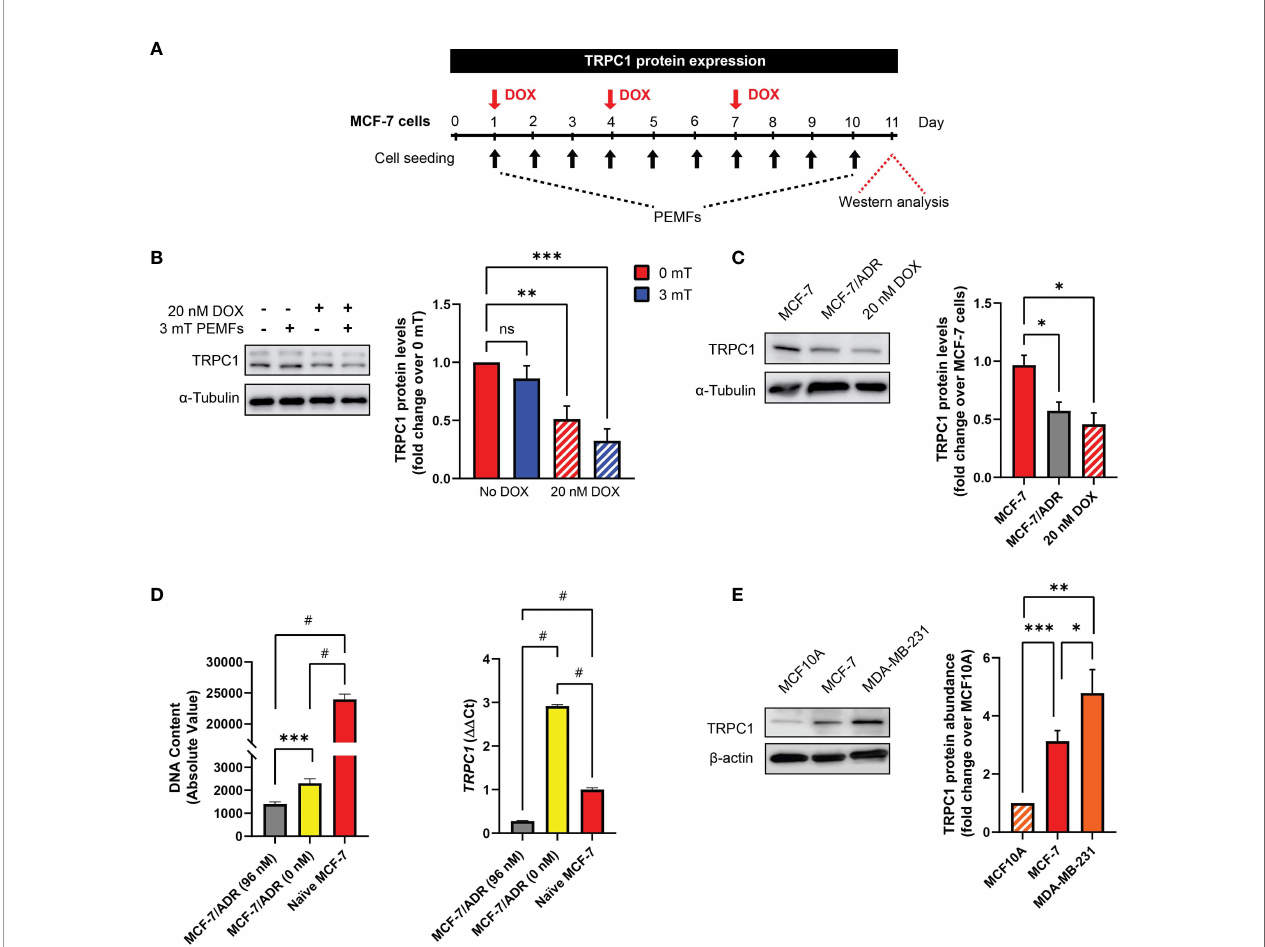
FIGURE 5 | DOX-chemoresistance is associated with TRPC1 channel downregulation. (A) PEMF (black arrows, 3 mT) and DOX (red arrow, 20 nM) regime used for TRPC1 protein analysis. (B) Representative western blot showing changes in TRPC1 after 11 days under the indicated conditions and corresponding quanti fi cation of TRPC1 protein levels normalized to unexposed 0 mT. Cells treated with DOX are represented by the hatched bars in combination with either 0 mT (red) or 3 mT (blue) PEMF exposure. (C) Western blot analysis of TRPC1 protein levels in MCF-7/ADR (96 nM DOX; gray) and 10-day 20 nM DOX-treated MCF-7 cells (hatched red) relative to naïve MCF-7 cells (red). Naïve MCF-7 and MCF-7/ADR cells were grown in culture for 3 days before protein analysis. (D) Comparison of cell growth (72 h post-seeding; left) and TRPC1 transcript levels (right) between MCF-7/ADR (96 nM), MCF-7/ADR (0 nM) and naïve MCF-7 cells. MCF-7/ADR (96 nM) cells were generated using incremental DOX levels up to a fi nal concentration of 96 nM (gray). Serial passaging of MCF7/ADR (96 nM) cells in the absence of DOX gave rise to MCF-7/ADR (0 nM) cells (yellow). (E) Western analysis of TRPC1 protein levels in non-malignant (MCF10A) and malignant breast cancer (MCF-7 and MDA-MB-231) cells after 48 h of growth under standard conditions. The corresponding bar chart shows the pooled data in fold change of TRPC1 expression normalized to MCF10A. All results presented were from 3 to 5 independent experiments with * p < 0.05, ** p < 0.01, *** p < 0.001 and # p < 0.0001. The error bars represent the standard error of the mean. “ ns ” indicates statistically nonsigni fi cant